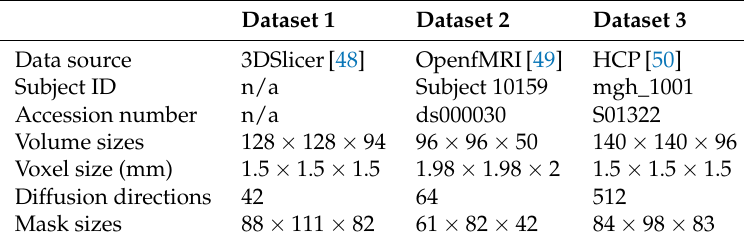
Table 1. Datasets used in the